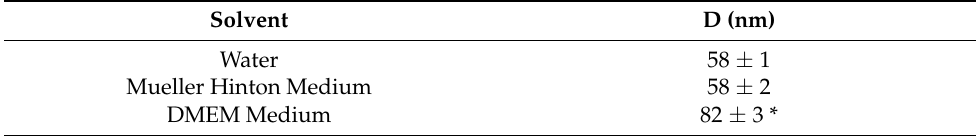
Table 1. Hydrodynamic diameter of ND-mTHPP in aqueous suspension, DMEM and MHB at 100 µ g/mL. * Value statistically different from the others ( p < 0.05).